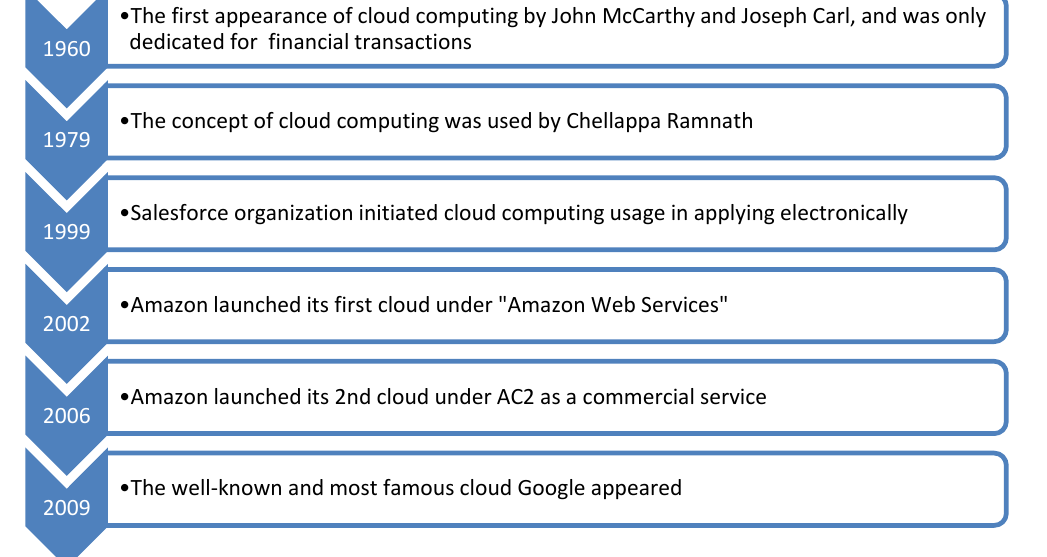
Fig. 2. The history of cloud computing (Kratzke,